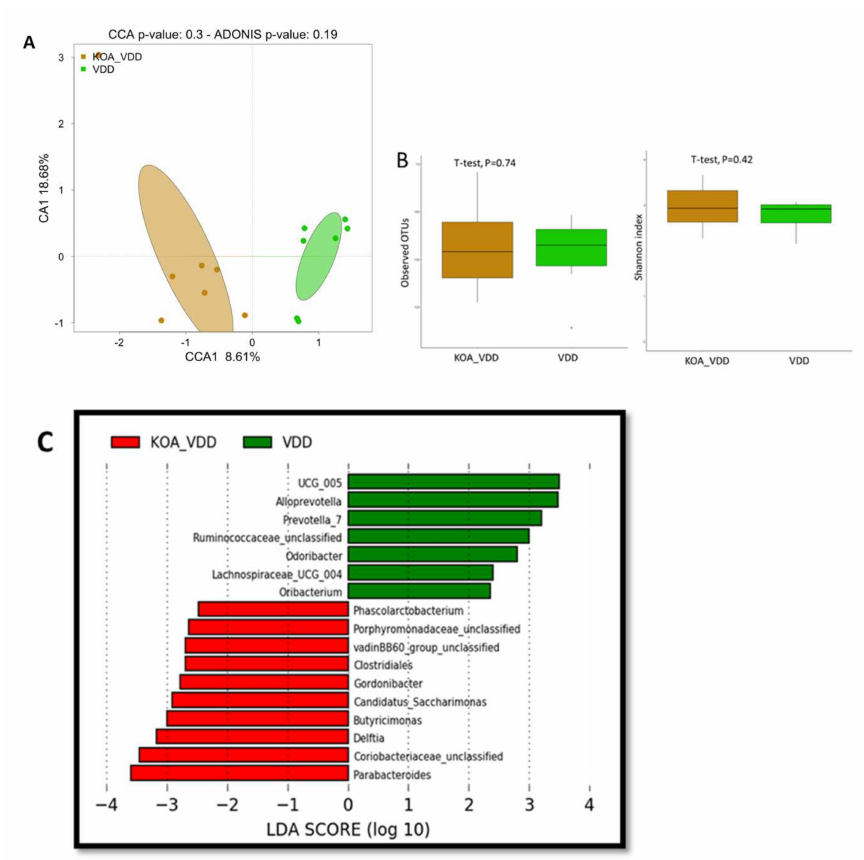
Figure 3. Knee osteoarthritis-associated dysbiosis in patients with D vitamin deficiency: ( A ) canonical correspondence analysis (CCA) was performed to study the beta diversity between stool microbiome in KOA_VDD and VDD patients; ( B ) Alpha-diversity using the observed OTU and Shannon index based on Bray–Curtis distances and ( C ) Histogram of the log 10 transformed LDA scores were computed for features that showed differential abundance between KOA_VDD and VDD